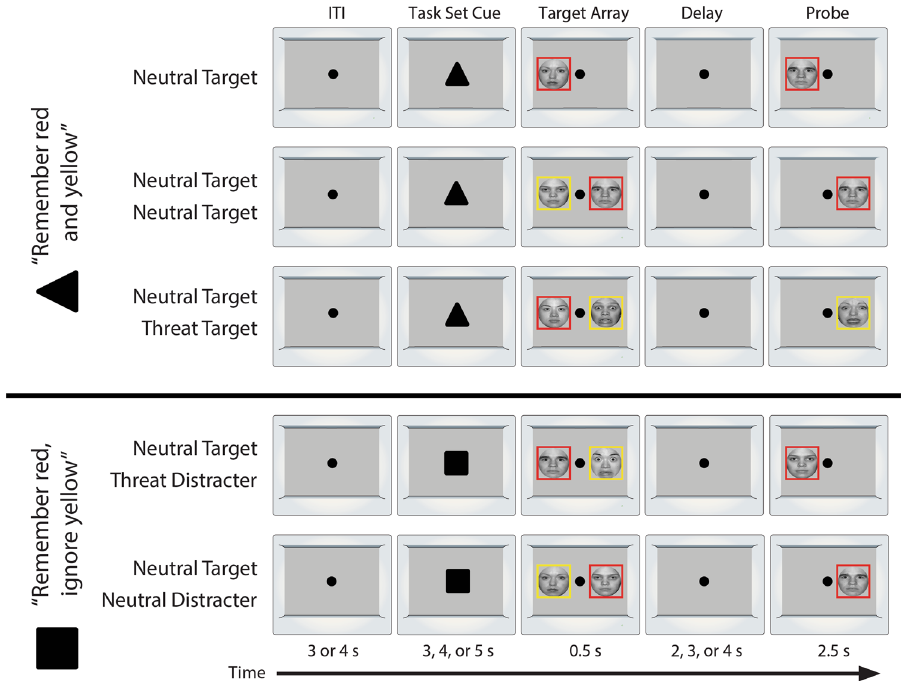
Figure 1. Emotional WM task. Rows depict conditions. Each trial began with a fixation dot, followed by a task set cue. Participants were instructed to either remember all face stimuli (triangle cue; top three rows), or to remember only the target face outlined in red and ignore the distracter face outlined in yellow (square cue; bottom two rows; colors counterbalanced across subjects). Next, the memory array was briefly presented (0.5 s). Following a variable-duration delay (2–4 s), a single probe face was presented. Subjects were instructed to identify whether the target face changed identity or not (equiprobable). On change trials, the identity of the model changed, whereas the expression (fearful or neutral) did not. Trials were separated by a 3–4 s inter-trial interval (ITI). Portions of this figure were adapted with permission from Macmillan Publishers Ltd: Nature Reviews Neuroscience, ref.